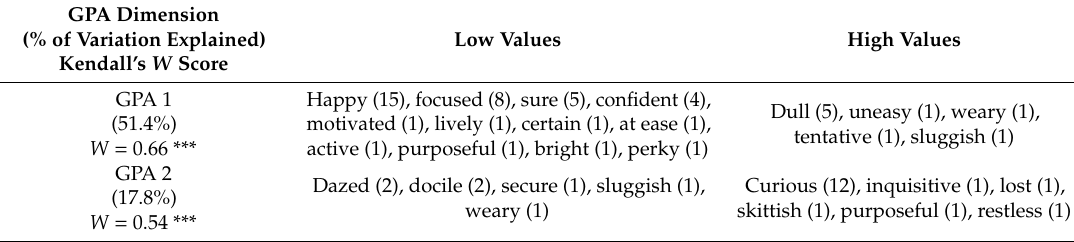
Table 1. Terms used by observers to describe the behavioural expression of lambs filmed in the paddock following routine painful husbandry practices (ear tagging, castration, mulesing and tail docking). Those terms that had strong loadings with the two main Generalised Procrustes Analysis (GPA) dimensions are listed. Terms with loadings > 0.6 (high values) and < − 0.6 (low values) are displayed for GPA dimension 1, and for GPA dimension 2, those with loadings > 0.4 (high values) and < − 0.4 (low values). Term order is determined first by the number of observers that used each term to assess lamb behaviour (with numbers presented in parentheses), and second by the loading of that